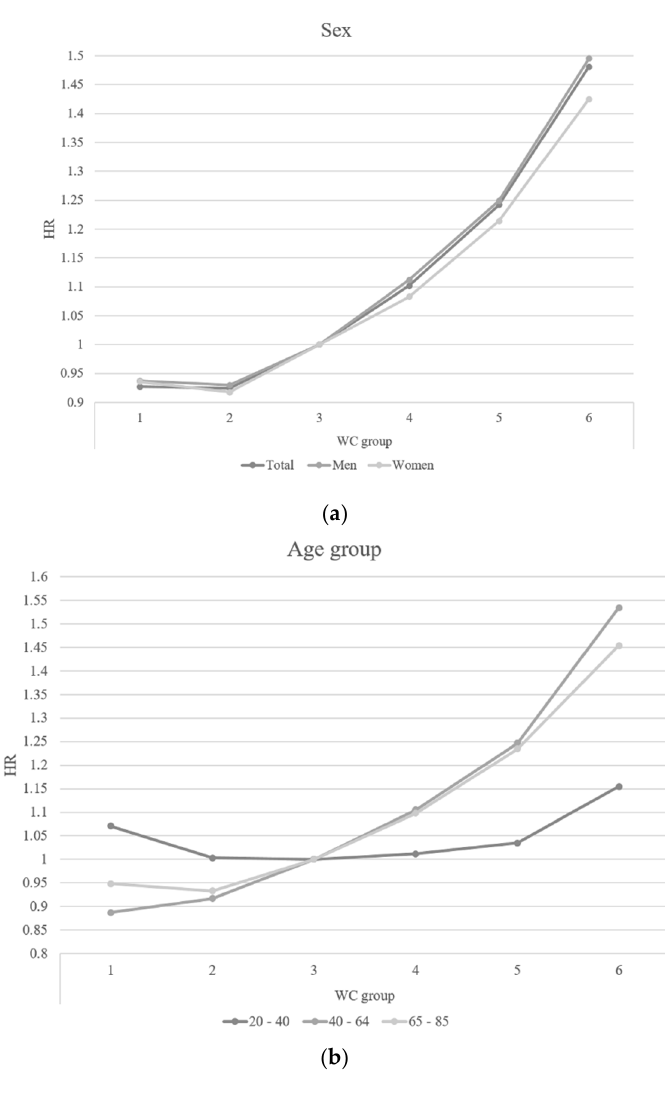
Figure 1. Hazard ratio for all-cause mortality by sex and age group in WC groups. ( a ) Sex: Adjusted for age, sex, smoking, drinking, exercise, income, and body mass index; WC: waist circumference, HR: hazard ratio, C.I.: confidence interval ( b ) Age group: Adjusted for age, sex, smoking, drinking, exercise, income, and body mass index; WC: waist circumference, HR: hazard ratio, C.I.: confidence interval.